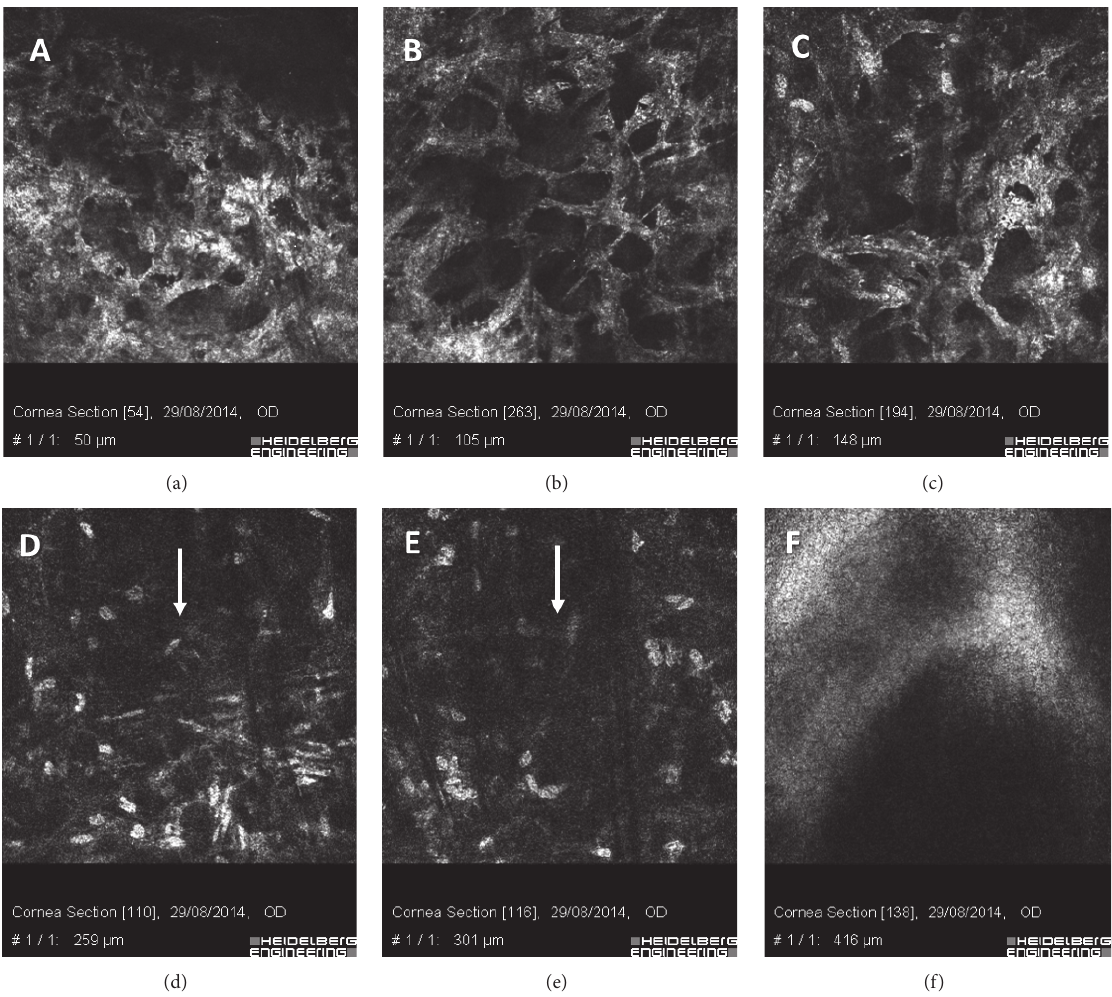
Figure 6: IVCM scans in the first month after high-irradiance topography-guided CXL. Different demarcation lines were documented at 150 𝜇 m depth in the flattest areas (48 D and under) irradiated at 7.2 J/cm 2 ((a), (b), and (c)); at 250 𝜇 m depth in the area ( > 48D and ≤ 52 D) irradiated at 10J/cm 2 E dose (d); at 300 𝜇 m depth in the steepest cone area ( > 52 D) irradiated at 15J/cm 2 E dose (e). IVCM also showed hyperreflectivity of corneal tissue and keratocytes apoptosis associated with dense trabecular patterned lacunar edema and nerve disappearance ((a), (b), and (c)). No endothelial damage was documented